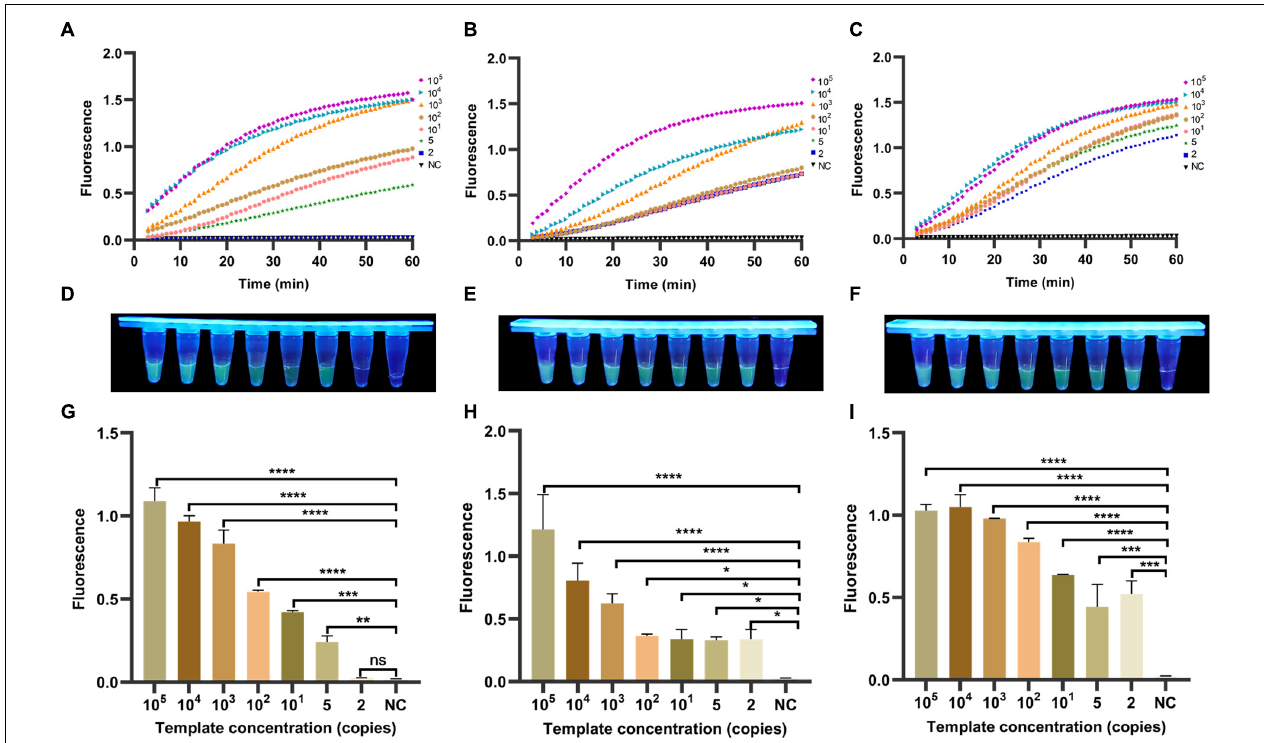
FIGURE 5 | Determination of sensitivity of one-tube RPA-CRISPR method for H. pylori . The fluorescence curves of (A) vacA , (B) cagA , and (C) 16SrDNA generated by Light Cycler 480 fluorescence detection system at each dilution within 60 min. The fluorescence intensity values with diluted templates of (D) vacA , (E) cagA , and (F) 16SrDNA are detected by UV device at 30 min, and the corresponding fluorescence values with diluted templates of (G) vacA , (H) cagA and (I) 16SrDNA are quantified by the Light Cycler 480 fluorescence detection system at 30 min. Negative controls (NC) were replaced with nuclease-free water, and the data were expressed in mean ± SD of the three sets of replicated experiments (ns: p > 0.05; * p < 0.05; ** p < 0.01; *** p < 0.001; **** p <